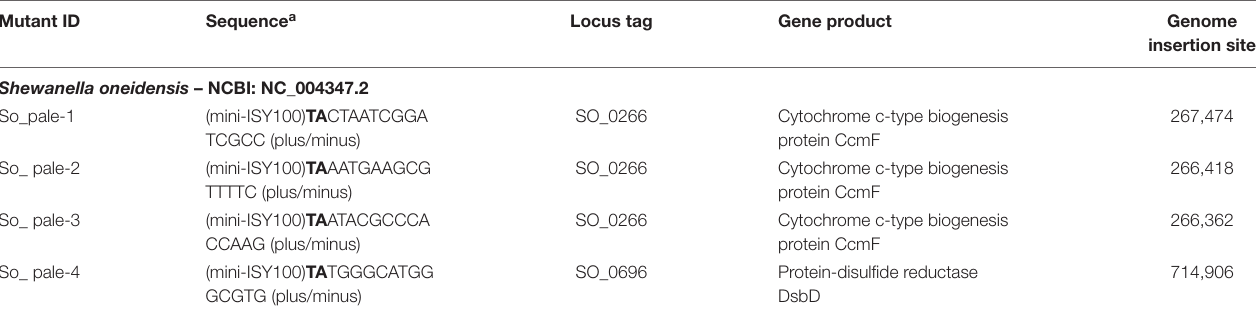
TABLE 5 | Genome insertion sites of the mini-ISY100 in S. oneidensis pale colored colonies. Mutant ID Sequence a Locus